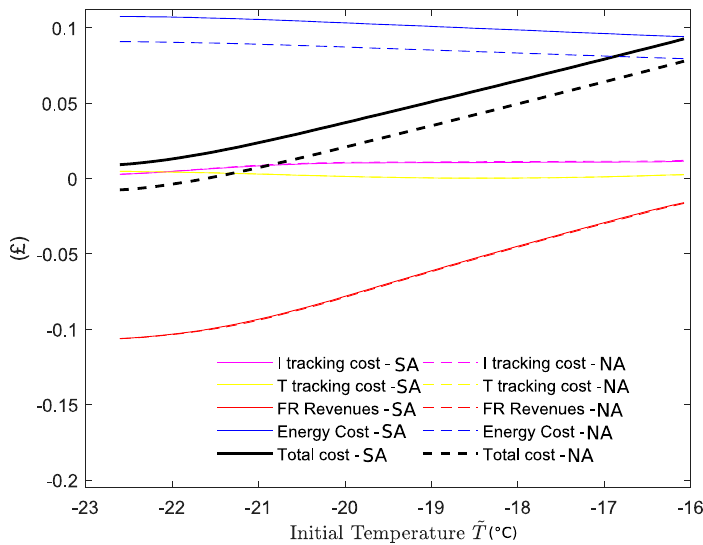
Figure 7. Breakdown of costs in (18) as function of initial temperature 𝑇(cid:3560) of single TCL in the NA (dashed) and in the SA (solid). Black lines for total costs, blue for energy costs, red for FR fees, yellow for 𝑇 -tracking and magenta for 𝐼 -tracking cost.